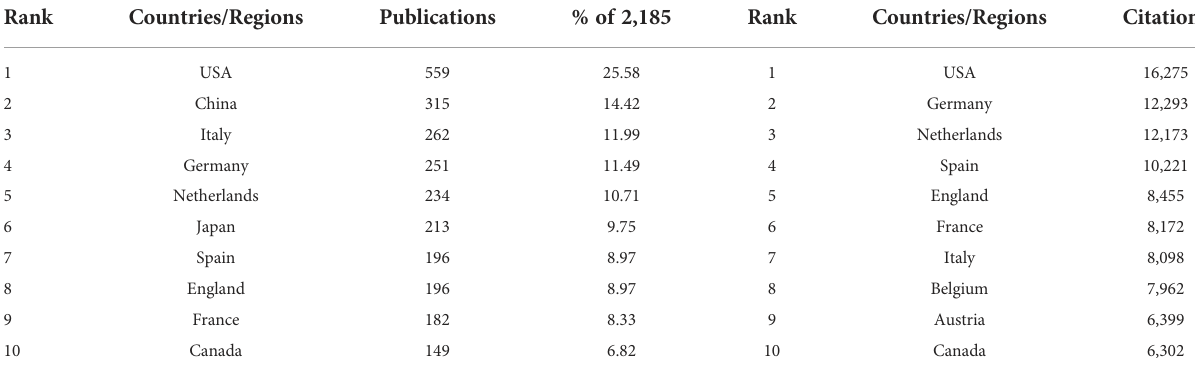
TABLE 1 Top 10 Countries/Regions by publications and